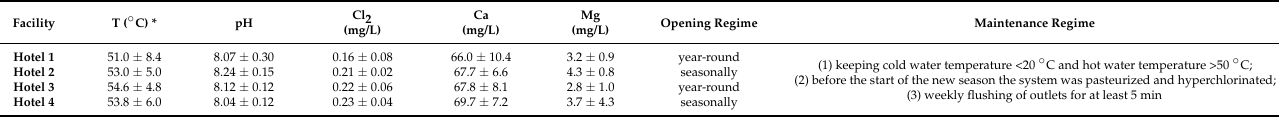
Table 2. Analyzed water parameters and characteristics of four hotels